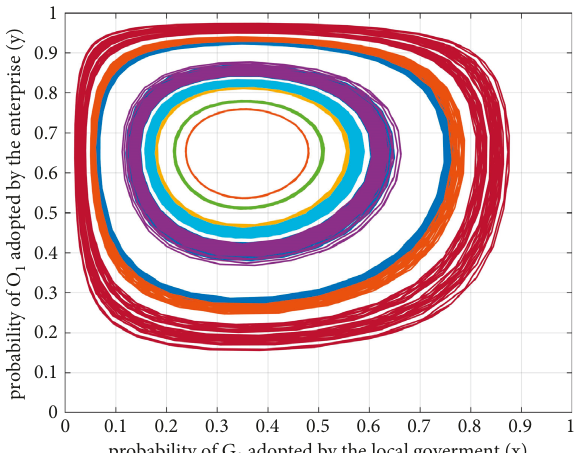
Figure 5: Dynamic evolutionary paths of local government and enterprise for system